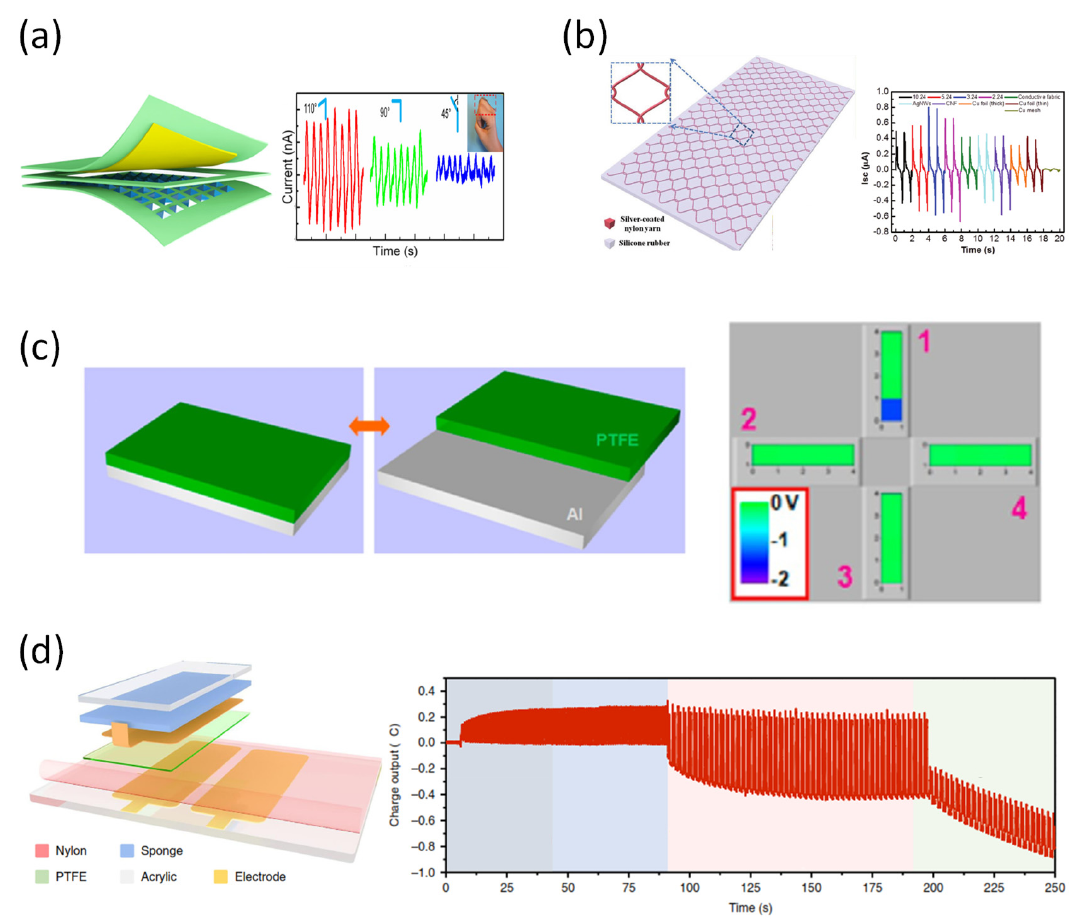
Figure 5. Familiar materials used for triboelectric and their triboelectric charge density [106].